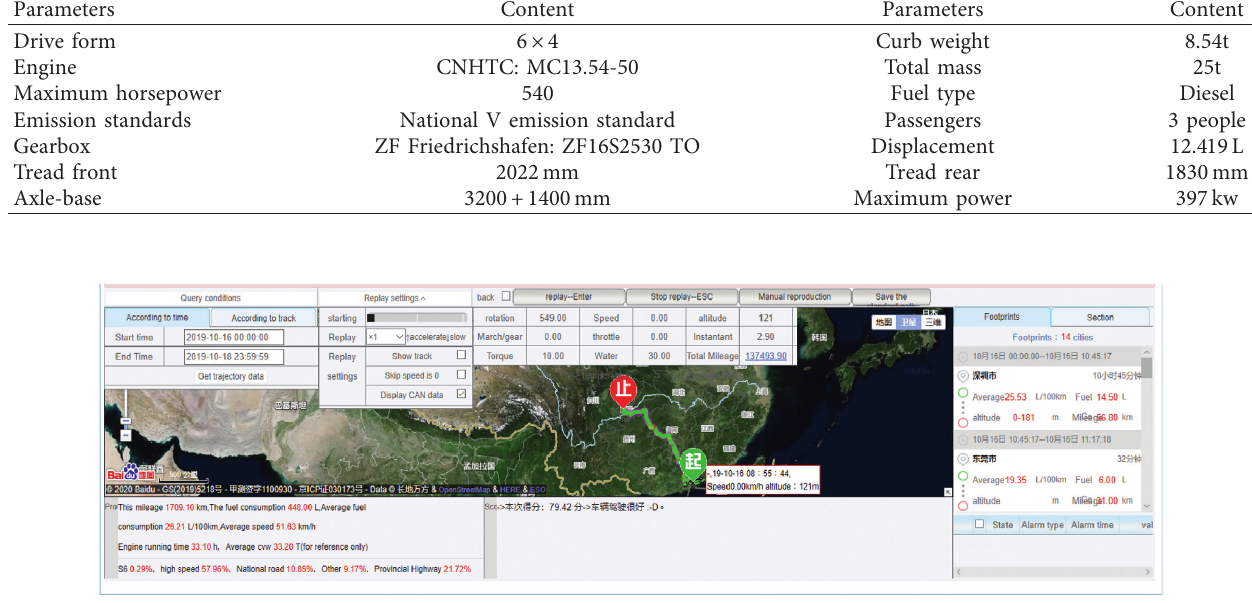
Figure 4: Advanced on-board measurement